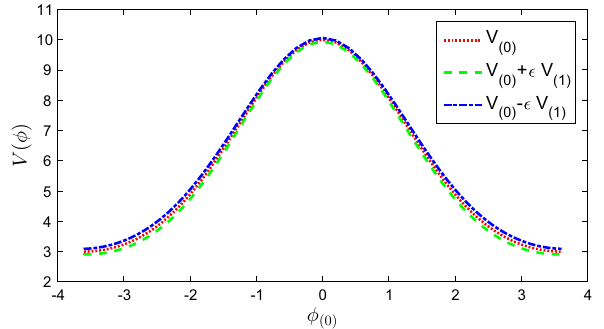
Fig. 14 Plot of the potential V (φ) and its first order correction, for the parameter values (cid:9) = 0.01, c = 0.5 and s = 1